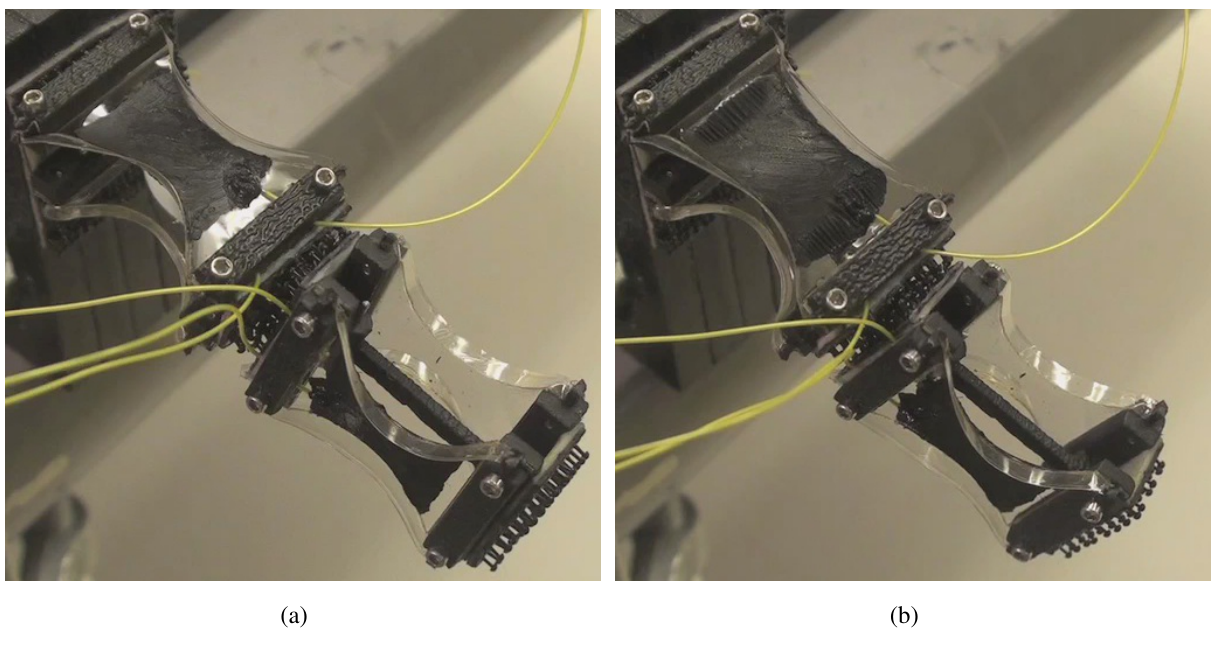
Figure 10. Two module configuration: one with the rotation axis perpendicular to gravity and the other with the rotation axis parallel to gravity at 0 V ( a ) and 3,500 V ( b